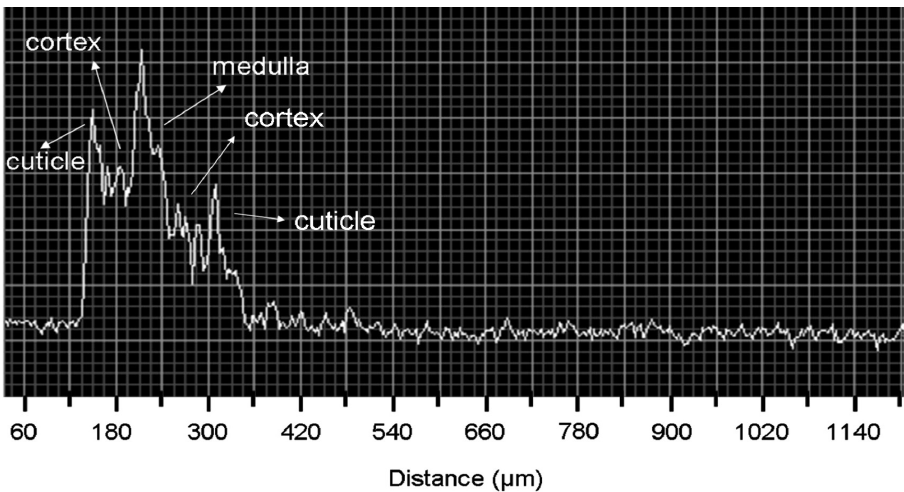
FIGURE 3 - Signal OCT profile for Afro-ethnic hair, showing the main structures.